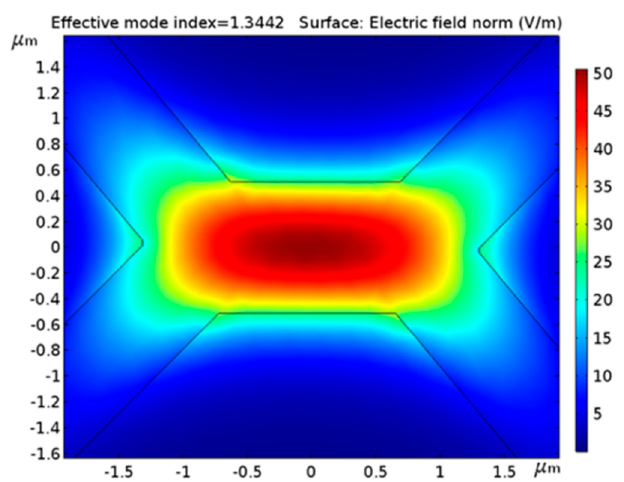
Figure 3. Suspended core fiber (SSC) cross-section LP 01 mode field distribution based on total internal reflection (TIR) theory.